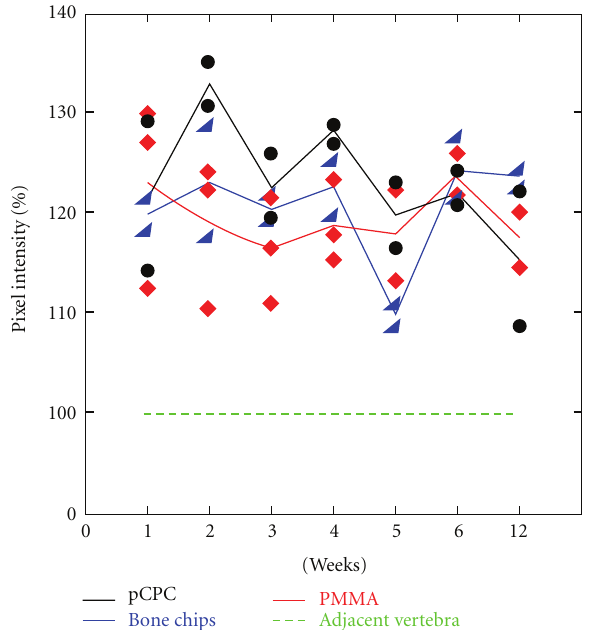
Figure 5: Diagram showing the osteoblast activity in the operated vertebra compared to the adjacent vertebra. The lines represent the mean value and the dots the individual animals value. The 12-week nano-SPECT/CT followup showed the highest osteoblast activity in the pCPC group during the first 5 weeks. Although the di ff erences between the three groups level o ff after the 5th week, pixel intensity stays higher in all three groups compared to the neighbouring healthy